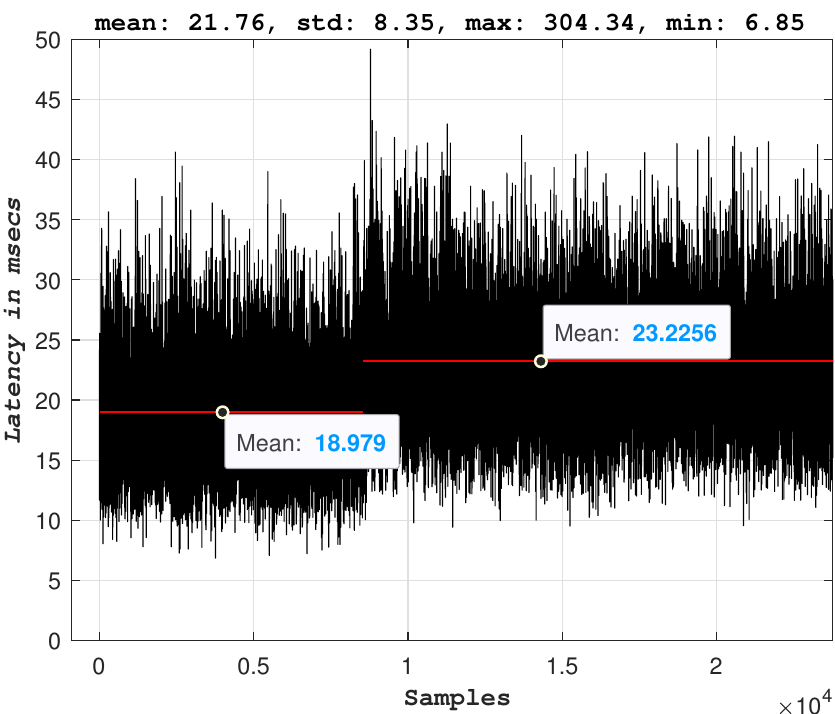
Figure 10. A 5G-UAV’s control data packets RTT when traffic from a competing 5G-UAV begins. A constant offset appears in the RTT